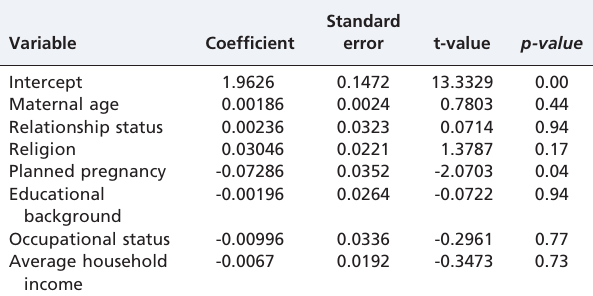
Table 3 - Standard multiple regression analysis.